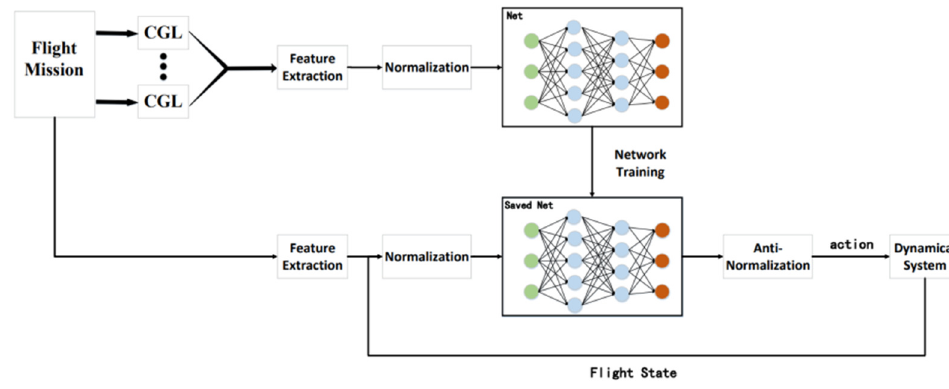
Figure 1. DNN-based real-time trajectory optimization.